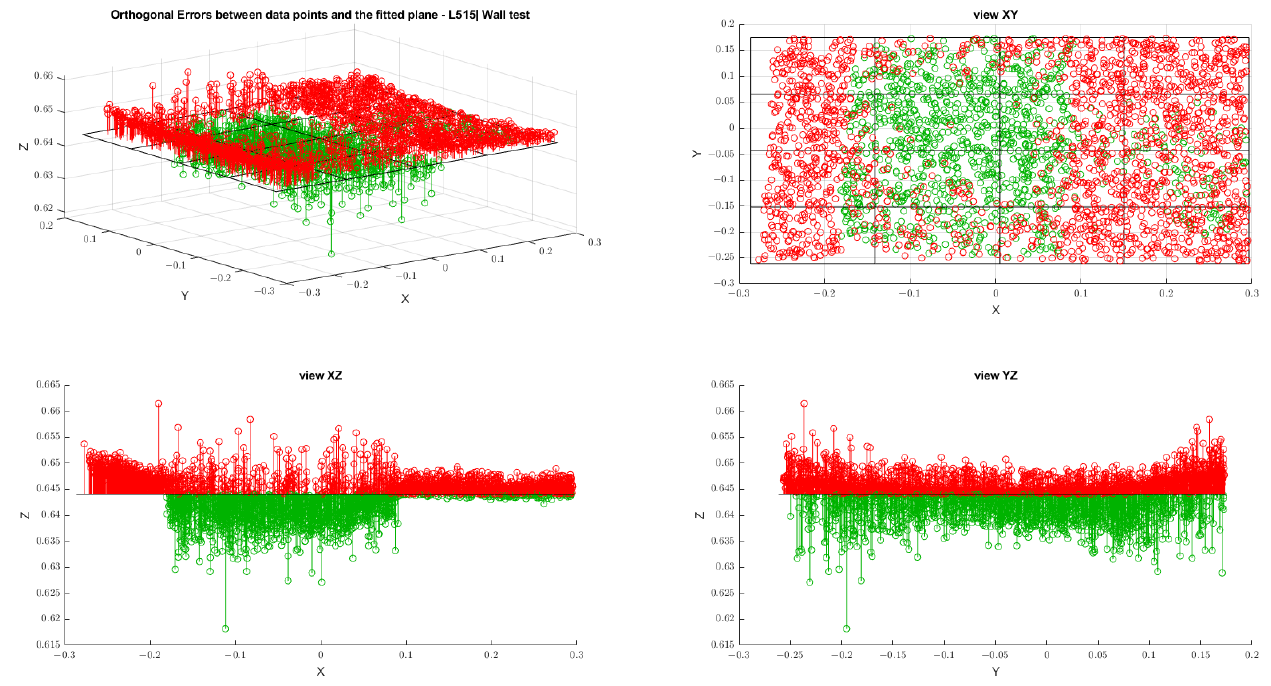
Figure A8. Results of orthogonal errors for the L515 camera referring to the wall